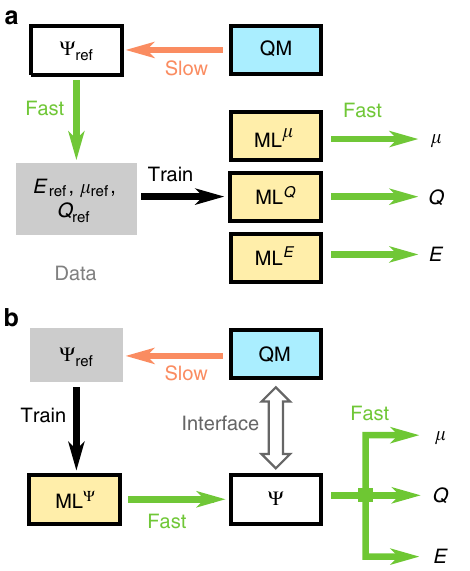
Fig. 1 Synergy of quantum chemistry and machine learning. a Forward model: ML predicts chemical properties based on reference calculations. If another property is required, an additional ML model has to be trained. b Hybrid model: ML predicts the wavefunction. All ground state properties can be calculated and no additional ML is required. The wavefunctions can act as an interface between ML and